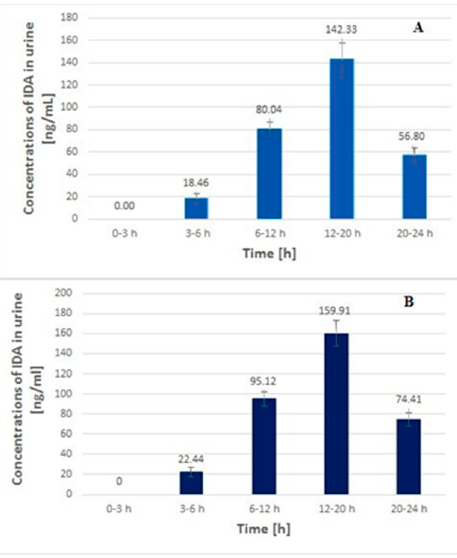
Figure 3. The concentration-time profiles of IDA in urine samples (mean ± SD, n = 3) from a 17-year-old child with RMA after oral administration of IDA, each at a dose of 10 mg, on the 1st day ( A ) and the 10th day ( B ) of the O-TIDA/O-TE therapy, according to the CWS-2006 protocol.